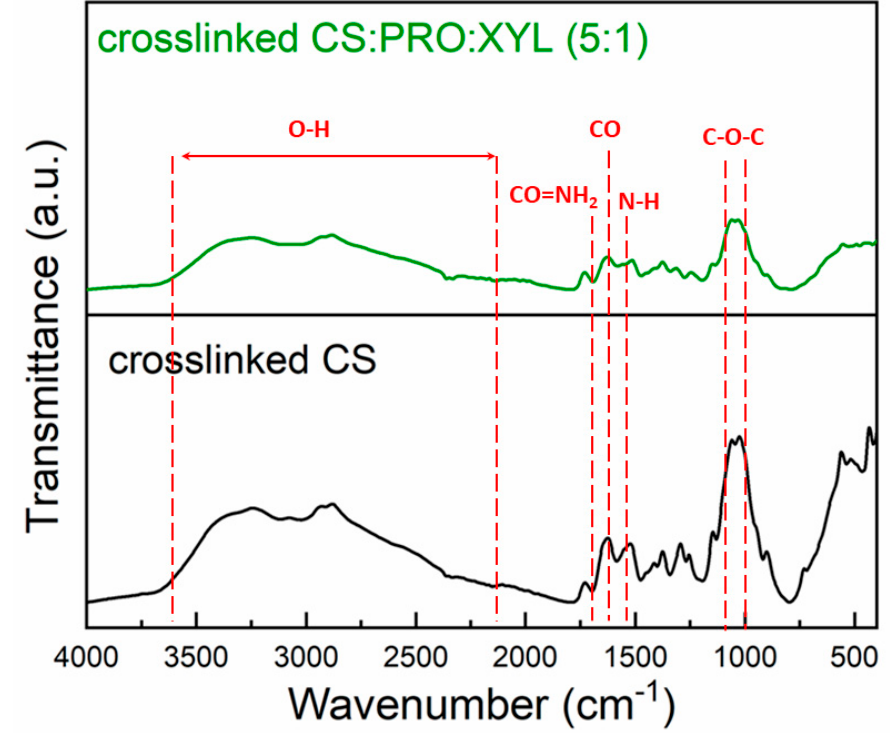
Figure 2. FTIR spectra for pristine crosslinked CS and CS:PRO: XYL membranes.